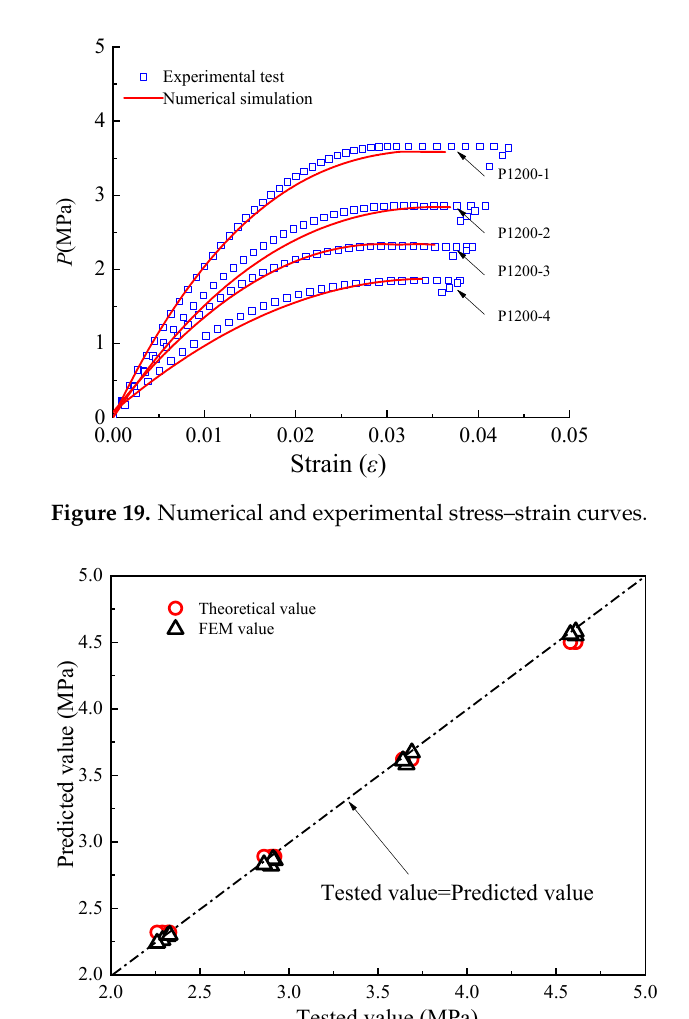
Table 3. Comparison of burst pressure results.